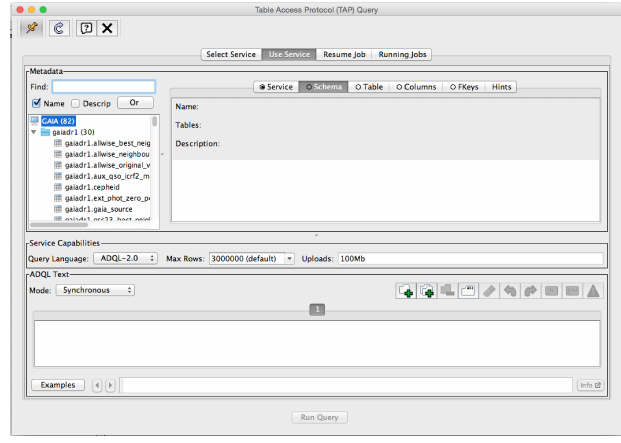
Fig. 56.— The TAP window with the GAIA service selected tables you can access using the chosen service. In this example, in the folder gaiadr1 (that is, from the first data release) you have gaiadr1.allwise best neighbour, gaiadr1.allwise best neighbourhood, and so on (which names are only partly visible in the window as it is shown above – expand the window by moving its boundaries if you need to!).